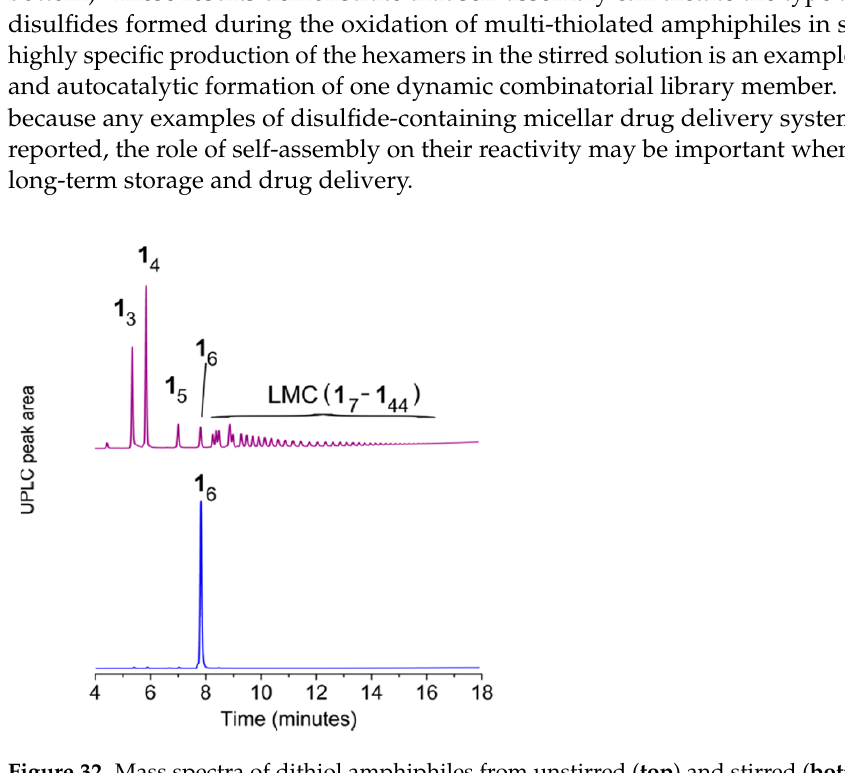
Figure 31. Oxidation and subsequent self-assembly of small dithiol amphiphiles with and without stirring. Reprinted with permission from [138]. Copyright (2017) American Chemical Society.